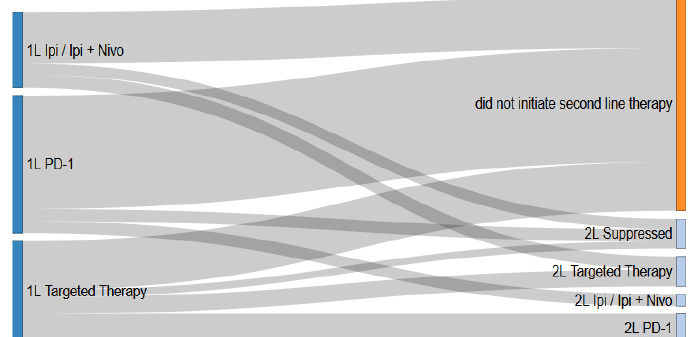
Figure 1. Treatment patterns of metastatic melanoma patients in Alberta, Canada from first-line to second-line therapy.